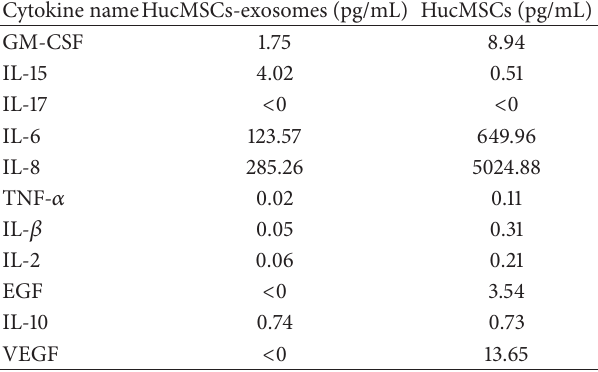
Table 1: Identification of cytokine from hucMSCs-exosomes and hucMSCs using